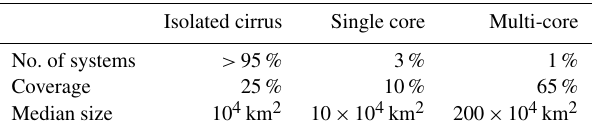
Table 1. Fraction of occurrence, coverage and median size for isolated cirrus systems, systems with one convective core and with multiple convective cores, over the latitude band 30 ◦ N–30 ◦ S shown as the annual average over the period